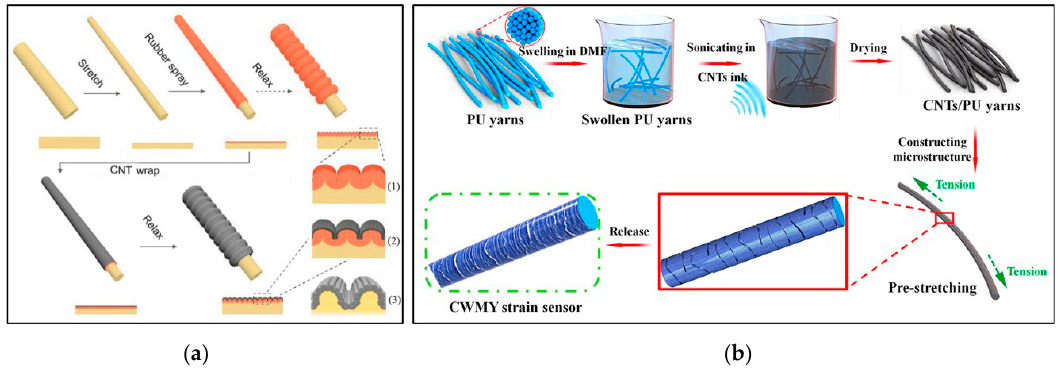
Figure 6. ( a ) The manufacturing steps of NTS m @rubber@fiber, the longitudinal cross-sections of the fibers of different manufacturing steps are shown below the rubber fiber. Yellow, red and gray are used for SEBS core, SGE layer and NTS sheath, respectively [89]. ( b ) Schematic diagram of prep- aration of WCMYSS [90].